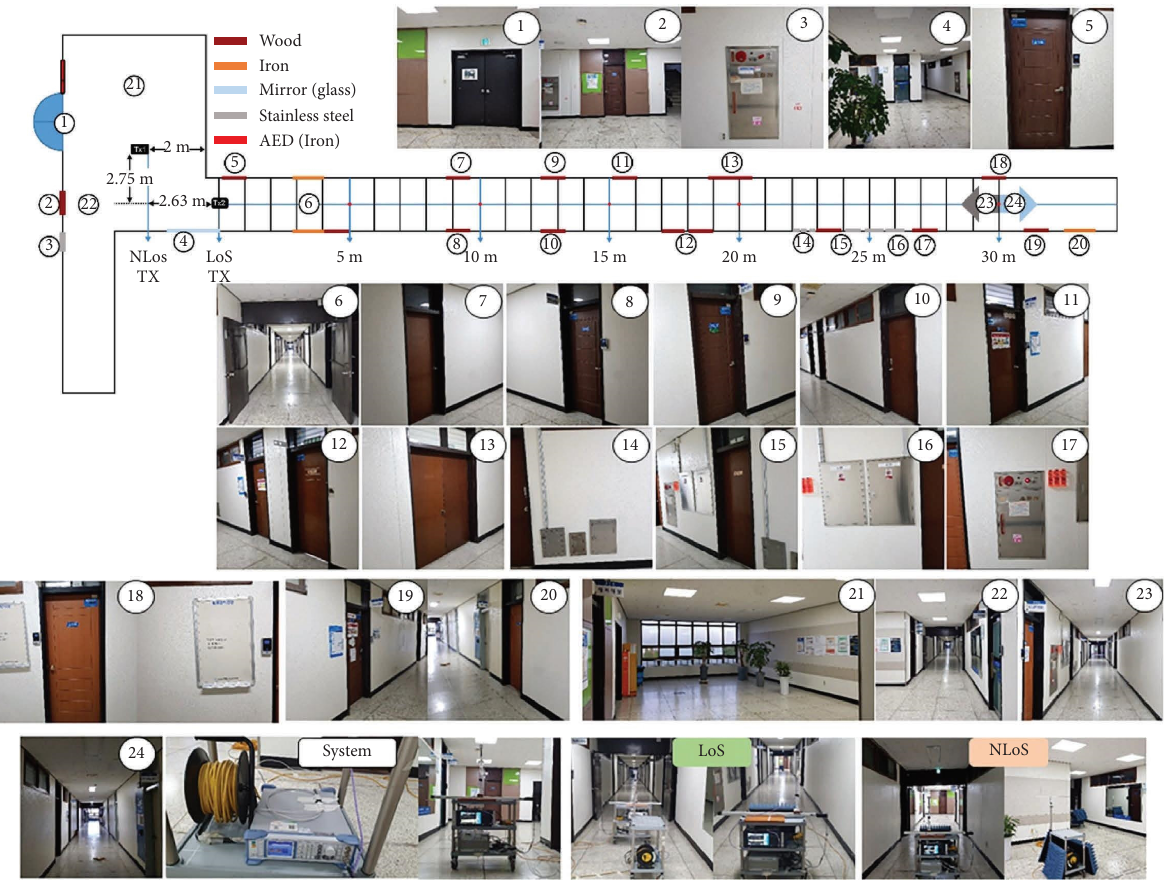
Figure 1: Scenario of the measured indoor corridor environment Table 1: Measurement points of local average power.